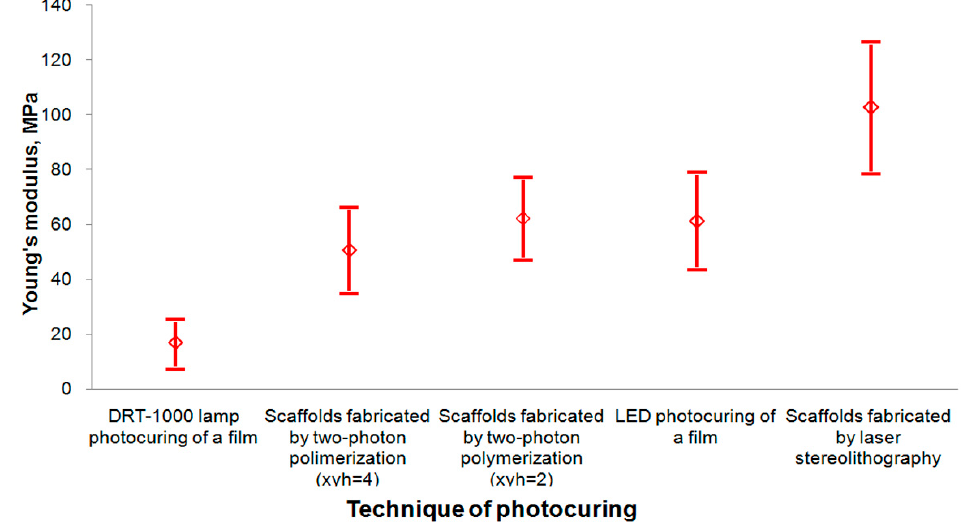
Figure 12. Dependence of Young’s modulus of 3D crosslinked structures (films and scaffolds) on